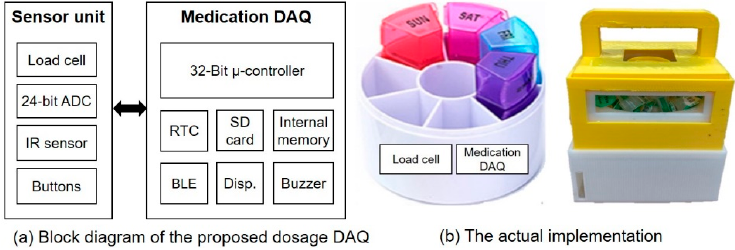
Figure 5. The proposed dosage information recorder. (BLE: Bluetooth low energy)